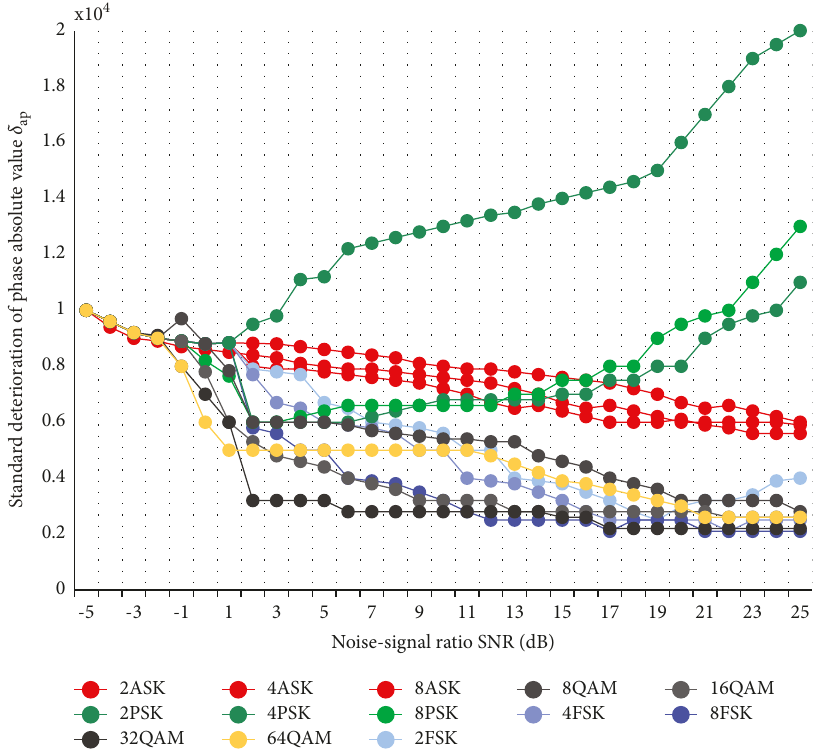
Figure 4: A variation curve of the feature δ ap with the signal-to-noise ratio under different social network crisis data